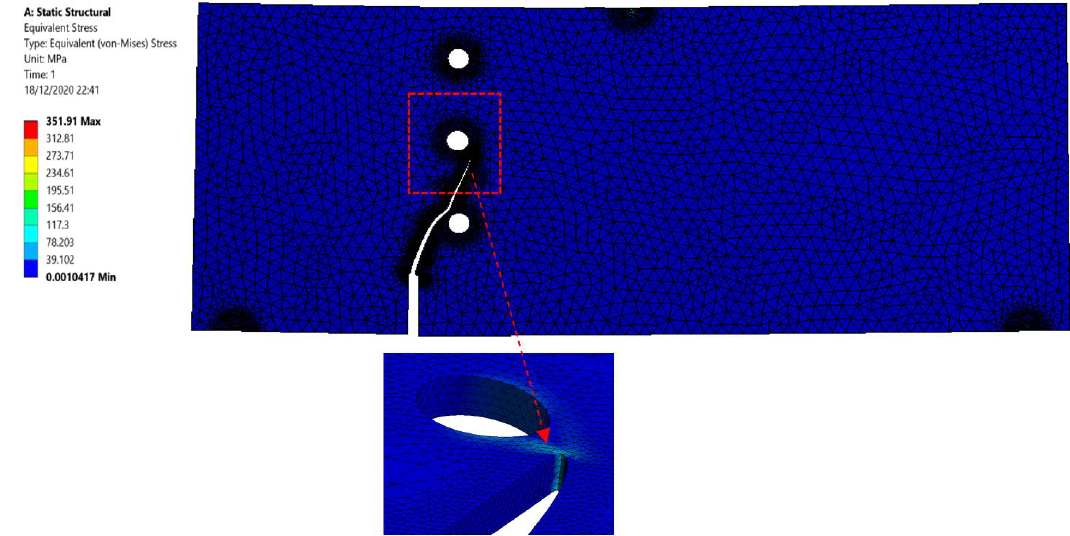
Figure 6. Equivalent Von-Mises stress distribution for specimen 1.